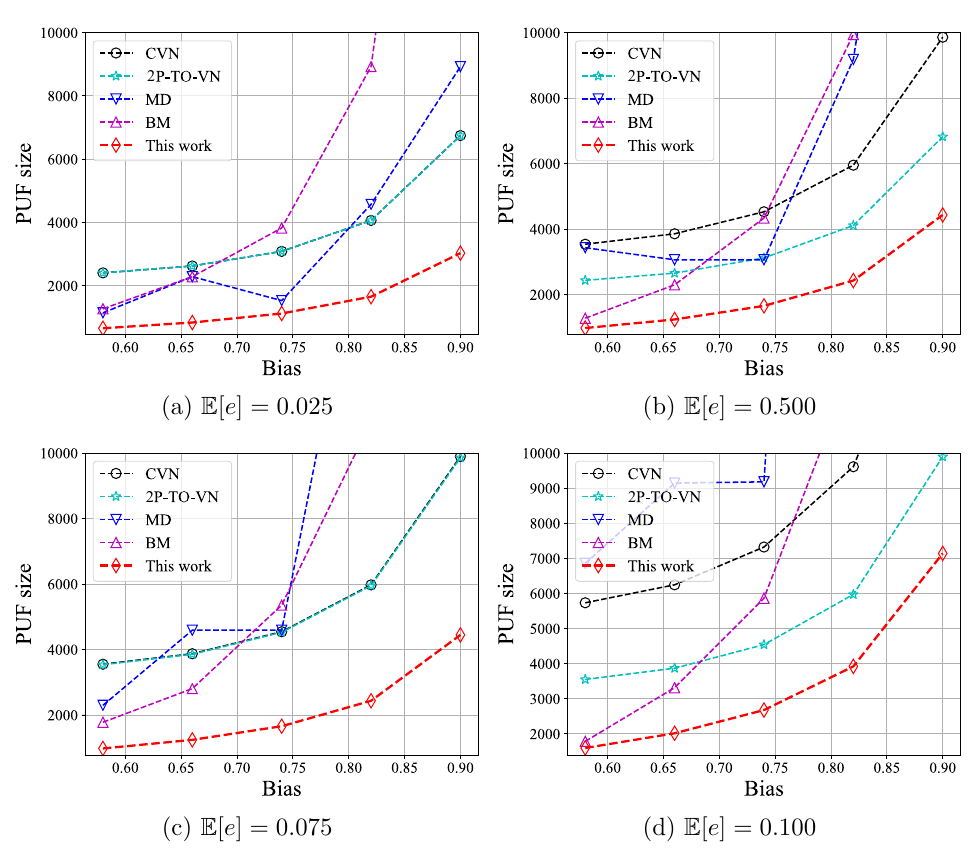
Figure 10: Comparison of AR-based FE with conventional debiasing-based FEs for binary PUF